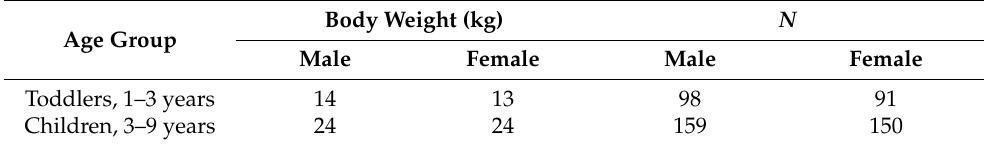
Table 2. Characteristics of the study sample [25].